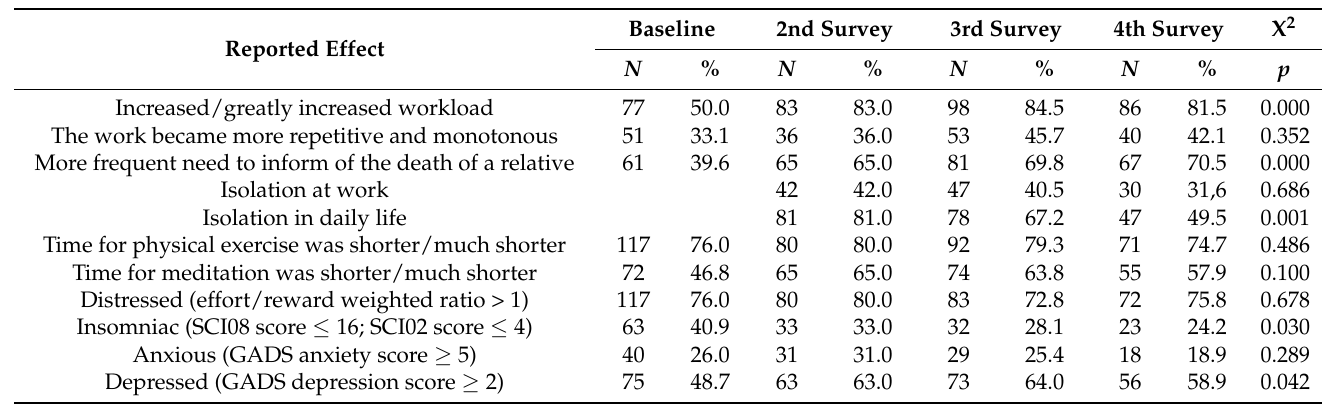
Table 3. Changes reported during the COVID-19 outbreak and prevalence of high stress, insomnia, anxiety, and depression during the four pandemic waves.